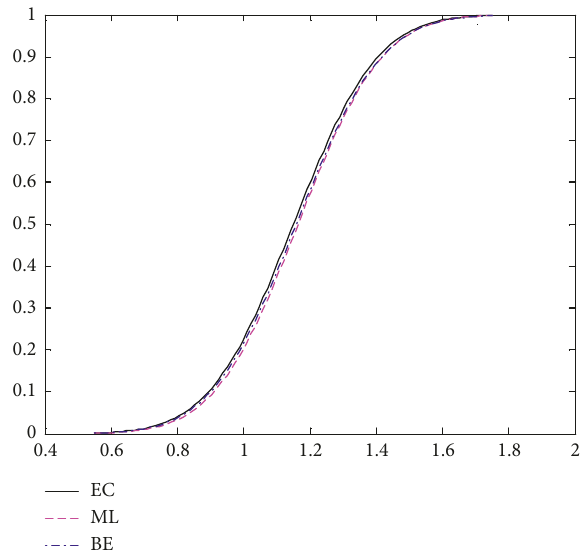
Figure 2: The cumulative distribution function curves according to different parameter estimation methods for the driven pile foun- dation (note: the horizontal ordinate is the random variable, and the longitudinal coordinate is the cumulative distribution function).